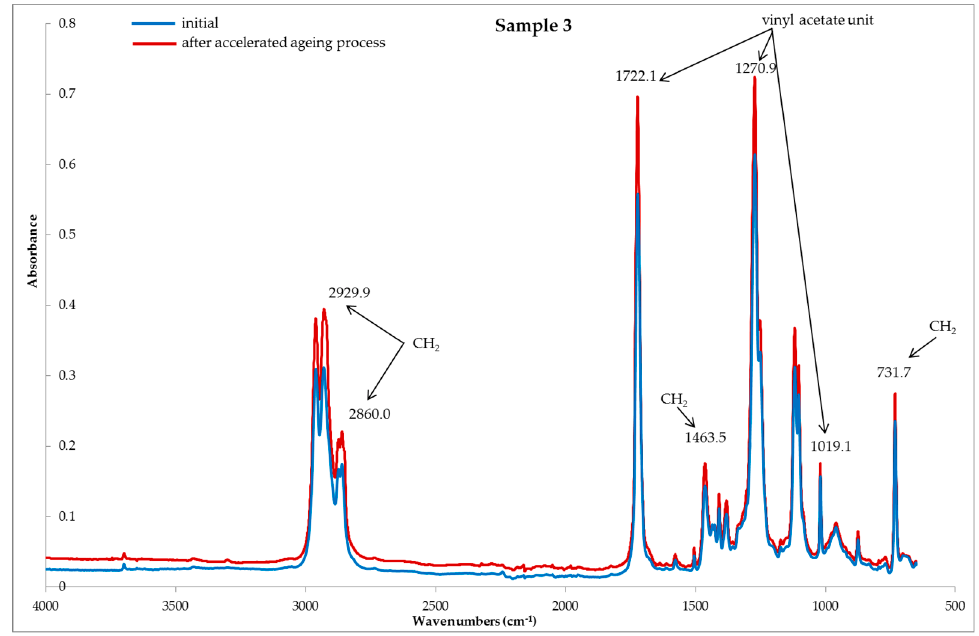
Figure 4. FTIR spectra of sample 3; samples, --- initial (before) and --- after the accelerated aging process.